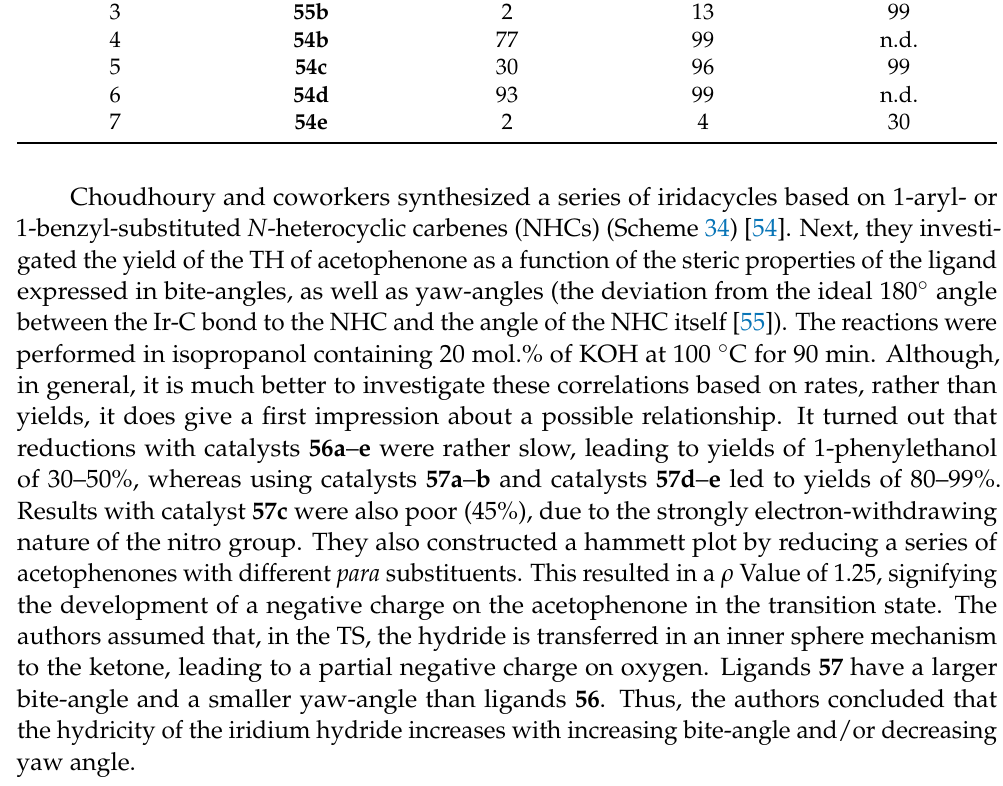
Choudhoury and coworkers synthesized a series of iridacycles based on 1-aryl- or 1-benzyl-substituted N -heterocyclic carbenes (NHCs) (Scheme 34) [54]. Next, they investi- gated the yield of the TH of acetophenone as a function of the steric properties of the